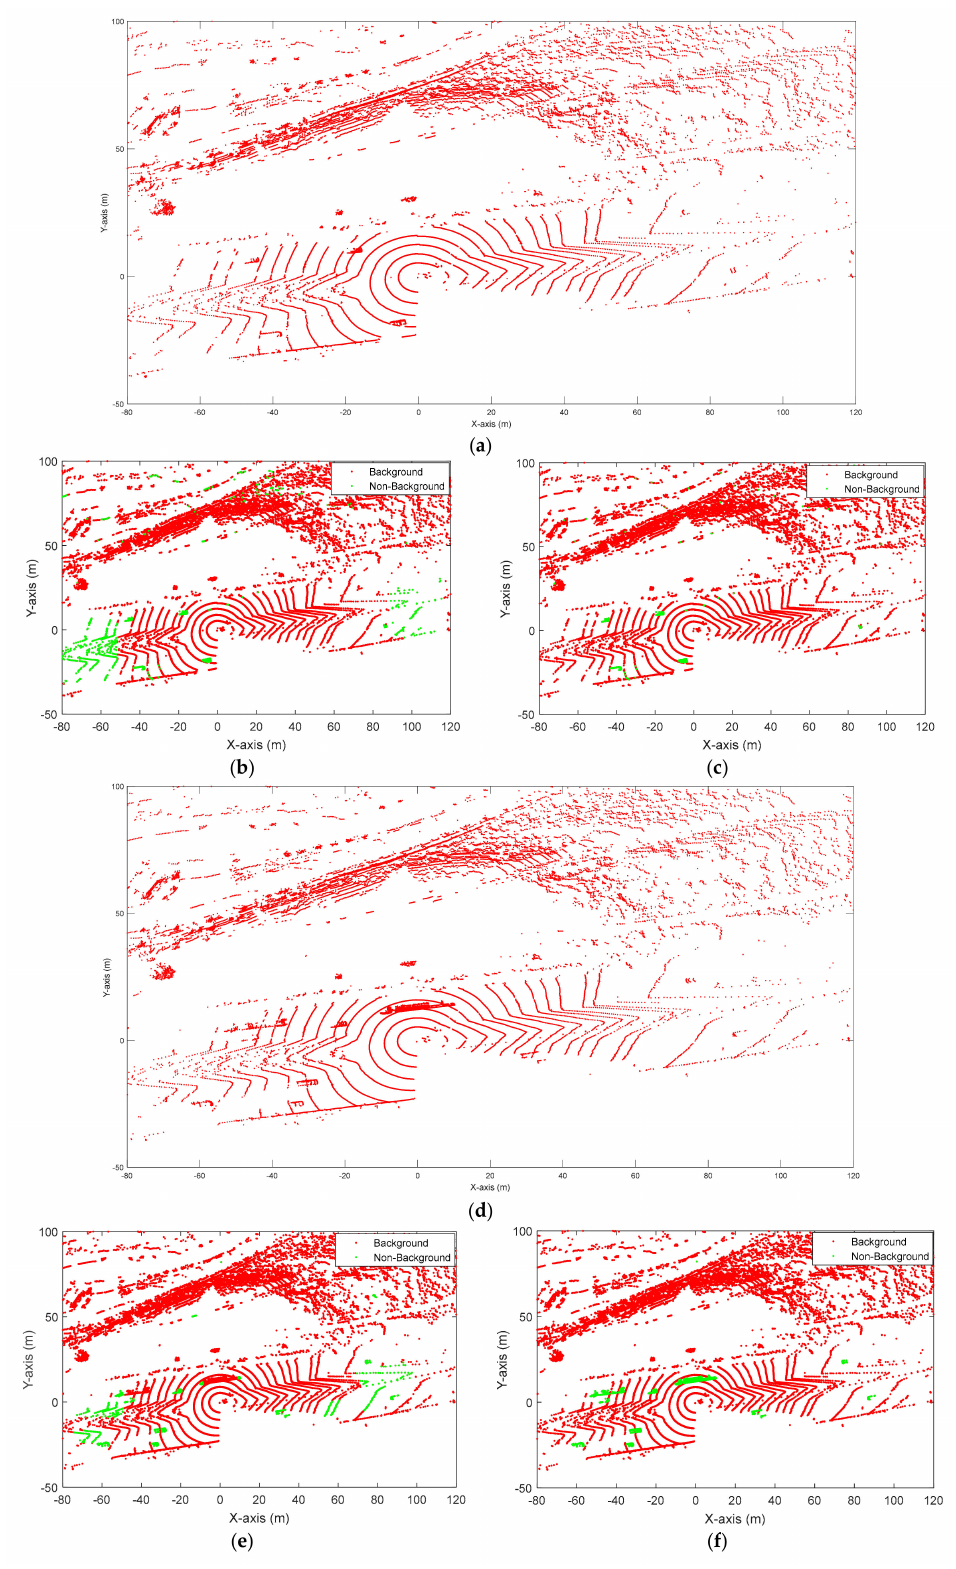
Figure 5. Performance of 3D-DSF and ground surface-enhanced density statistic filtering method (GS-DSF) under windy weather: ( a ) Free-flow: Raw light detection and ranging (LiDAR) data before background filtering, ( b ) Free-flow: 3D-DSF, ( c ) Free-flow: GS-DSF, ( d ) Congested tra ffi c: Raw LiDAR data before background filtering, ( e ) Congested tra ffi c: 3D-DSF, ( f ) Congested tra ffi c: